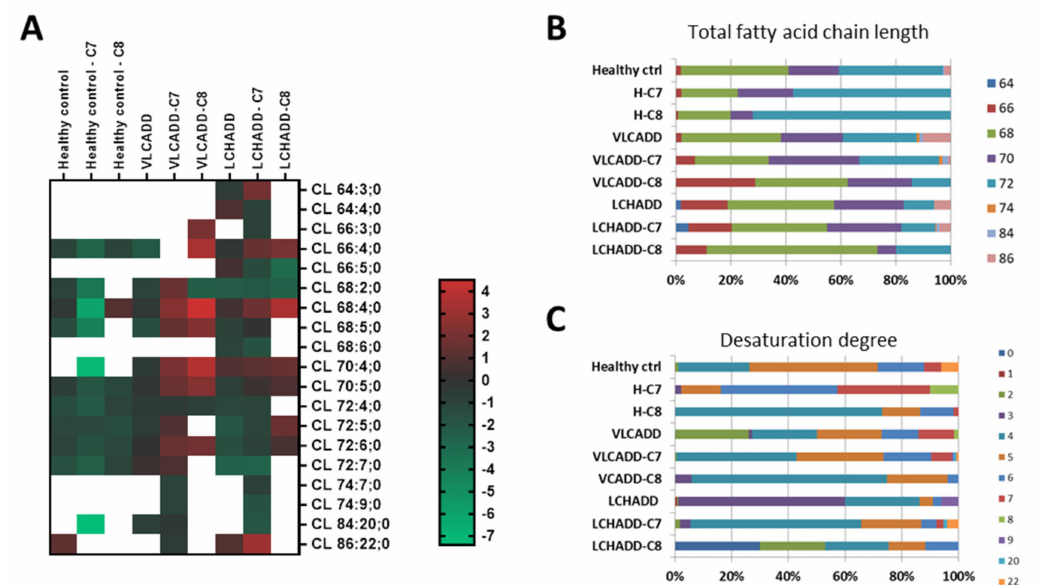
Figure 4. Disease-specific alteration of cardiolipins in healthy controls and VLCADD and LCHADD fibroblasts. ( A ) Heatmap of log2 transformed concentration of specific cardiolipin species. ( B ) Change of total fatty acid chain length. ( C ) Representation of the desaturation degree. Concentrations of the measured fatty acid chain length are represented as percentage. Mol% sample: indicates the moles of the lipid species extracted from one sample calculated as percentage of the total amount of lipid